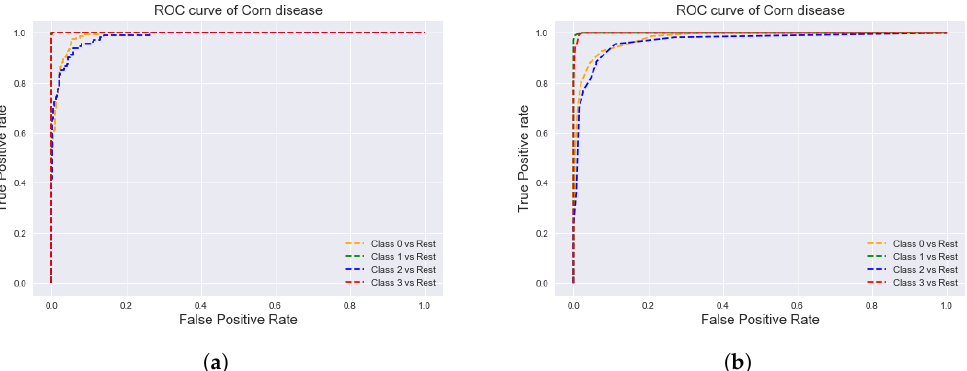
Figure 9. AUC-ROC curve of corn diseases ( a ) shallow VGG with Xgboost ( b ) shallow VGG with